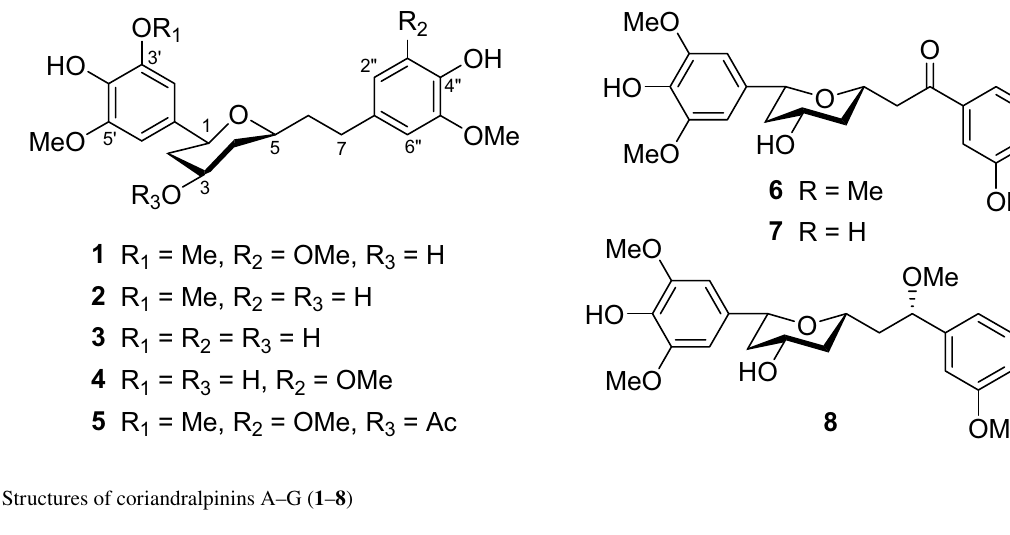
(Fig. 2), correlations of H-1 with C-1 ′ , -2 ′ , and -6 ′ and of H -7 with C-1 ′ ’, -2 ′ ’, and -6 ′ ’ suggested that the two phenyl 2 rings were connected to the alkyl chain terminal carbons C-1 and C-7, respectively. In addition, correlations of H-1/C-5 and H-5/C-1 indicated that C-1 was linked to C-5 via an oxygen atom to form a tetrahydropyran unit. The relative stereochemistry of 1 was elucidated on the basis of proton coupling constants and NOESY correlations. In the 1 H NMR spectrum, H-1 ( δ 4.26) and H-2ax ( δ 1.50) appeared as a H H double doublet ( J = 11.4, 2.0 Hz) and an apparent quartet ( J = 11.4 Hz), respectively, suggesting that H-1 and H-3 ( δ H 3.94) are both in axial positions. The remaining oxymethine proton H-5 was also assigned to be axial by the NOE inter- actions observed for H-5/H-1 and H-5/H-3 (Fig. 2). Based on the established relative configuration, the absolute con- figuration of 1 was assigned by electronic circular dichroism (ECD) spectrum aided with ECD/TDDFT calculations. The